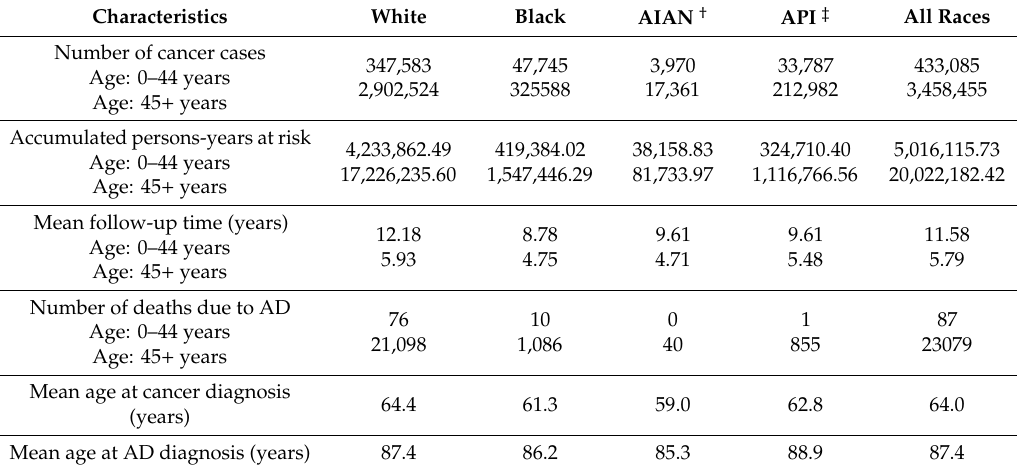
Table 1. Cohort characteristics (all cancer sites